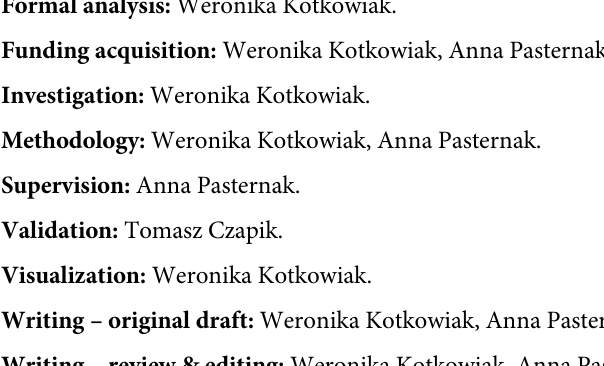
S4 Table. Thermodynamic parameters of G-quadruplex formation of TBA variants